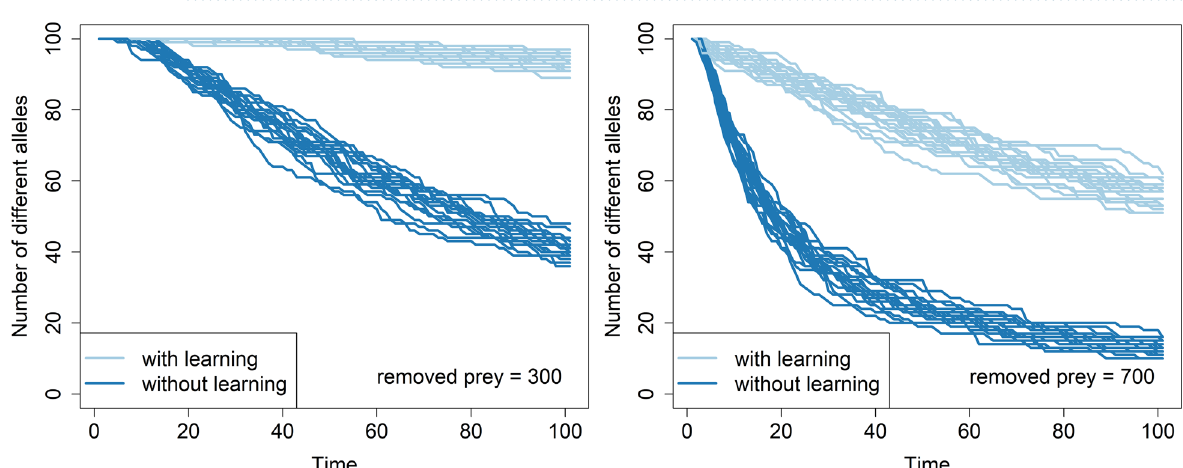
Figure 5. Learning often prolongs generation time. The heatmaps show the mean difference in generation time between learning and non-learning scenarios. Predators kill the same number of individuals in both learning and non-learning scenarios to allow for a fair comparison. The upper bound on the probability of avoiding or escaping a predator attack is set to 0.99. The values in the heatmap are averages from 10 simulation runs. The learning occurs at the end of each timestep in the left panel and after every unsuccessful predator attack in the right panel.